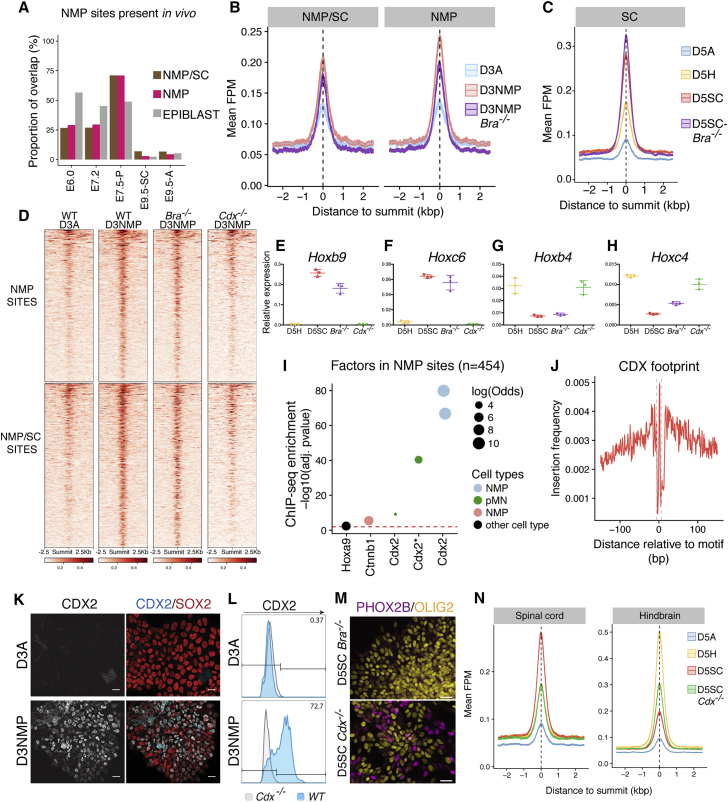
WNT Establishes Spinal Cord Identity via CDX-Dependent Chromatin Remodeling(A) Proportion of NMP, NMP/SC, or epiblast genomic sites from the SOM (Figure 2A) that overlap with accessible regions in vivo (Neijts et al., 2016; this study). 71% of all NMP sites identified in vitro are found in the posterior E7.5 embryo (E7.5-P; Neijts et al., 2016). This contrasts with NPs from the spinal cord (E9.5-SC) or anterior nervous system (E9.5-A; this study), which show little overlap with these sites.(B) The average accessibility profile of NMP/SC and NMP-specific sites in wild-type versus T/Bra−/− mutant cells. These sites remain accessible in T/Bra−/− mutant cells at D3 of the spinal cord differentiation.(C) T/Bra−/− mutant cells differentiated to D5 under spinal cord conditions retain accessibility at spinal cord genomic sites.(D) Heatmap showing NMP (top panels) and NMP/SC (bottom panels) site accessibility in D3NMP conditions from WT, T/Bra−/−, and Cdx1/2/4 (Cdx−/−) mutant cells. These sites are maintained in the absence of T/Bra but are reduced in the absence of the three Cdx TFs.(E–H) qRT-PCR of Hox genes at D5 indicates AP identity of hindbrain (D5H) and spinal cord (D5SC) cells in wild-type compared with T/Bra−/− and Cdx−/− mutant cells differentiated under spinal cord conditions. Bra−/− mutant cells retain expression of spinal cord Hox genes Hoxb9 (E) and Hoxc6 (F) in contrast to Cdx mutant cells, which express Hoxb4 (G) and Hoxc4 (H). Error bars represent the standard deviation.(I) ChIP-seq enrichment analysis reveals that CDX2 is highly enriched at NMP-specific sites (p values; one-sided Fisher’s exact test; multiple testing corrected using Benjamini-Hochberg procedure).(J) Tn5 insertion frequency, across all SOM regions containing at least one CDX2 motif, at nucleotide resolution in D3NMP cells reveals the presence of a footprint centered on the CDX2 motif.(K) CDX2 (cyan) and Sox2 (red) immunofluorescence at D3. Scale bars represent 20 μm.(L) Histogram of CDX2-positive cells at D3 comparing WT (blue) with Cdx−/− mutant cells (gray), determined by flow cytometry. Numbers indicate percentage of SOX2-positive cells that are CDX2 positive.(M) Removal of the three Cdx transcription factors Cdx1/2/4 results in the continued induction of OLIG2 (gold) and ectopic production of cranial MN progenitors, marked by PHOX2B (magenta). Scale bars represent 20 μm.(N) The average profile of spinal cord sites (left plot) shows that, relative to D5 spinal cord (D5SC, red), accessibility at these sites is reduced in Cdx−/− mutant cells differentiated under the same conditions (D5SC Cdx−/−, green), to the same extent as D5 hindbrain cells (yellow). Under spinal cord conditions, Cdx mutant cells show increased accessibility at hindbrain sites (right plot).